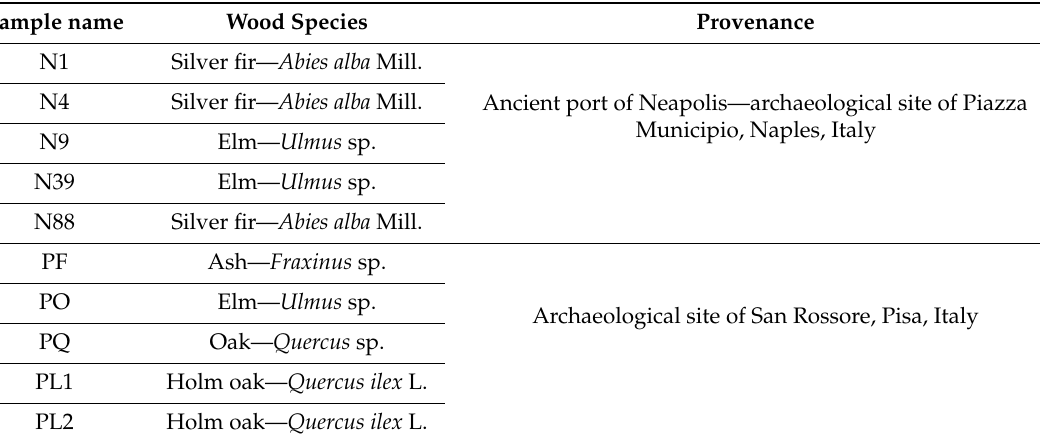
Table 1. List of waterlogged archaeological wood samples used for the